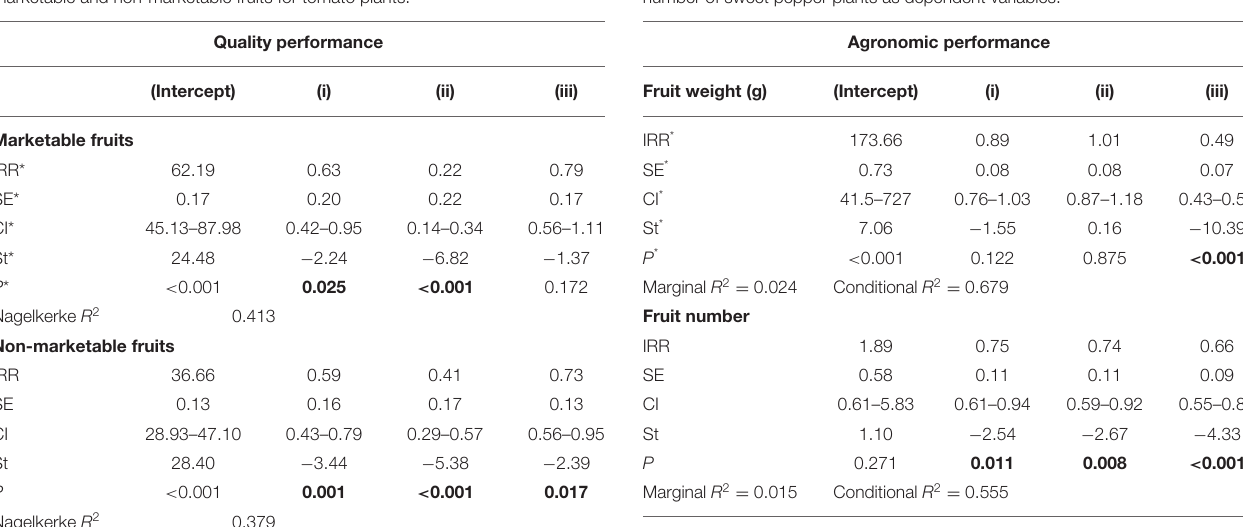
TABLE 5 | Factors influencing agronomic performance via fruit weight and fruit number of sweet pepper plants as dependent